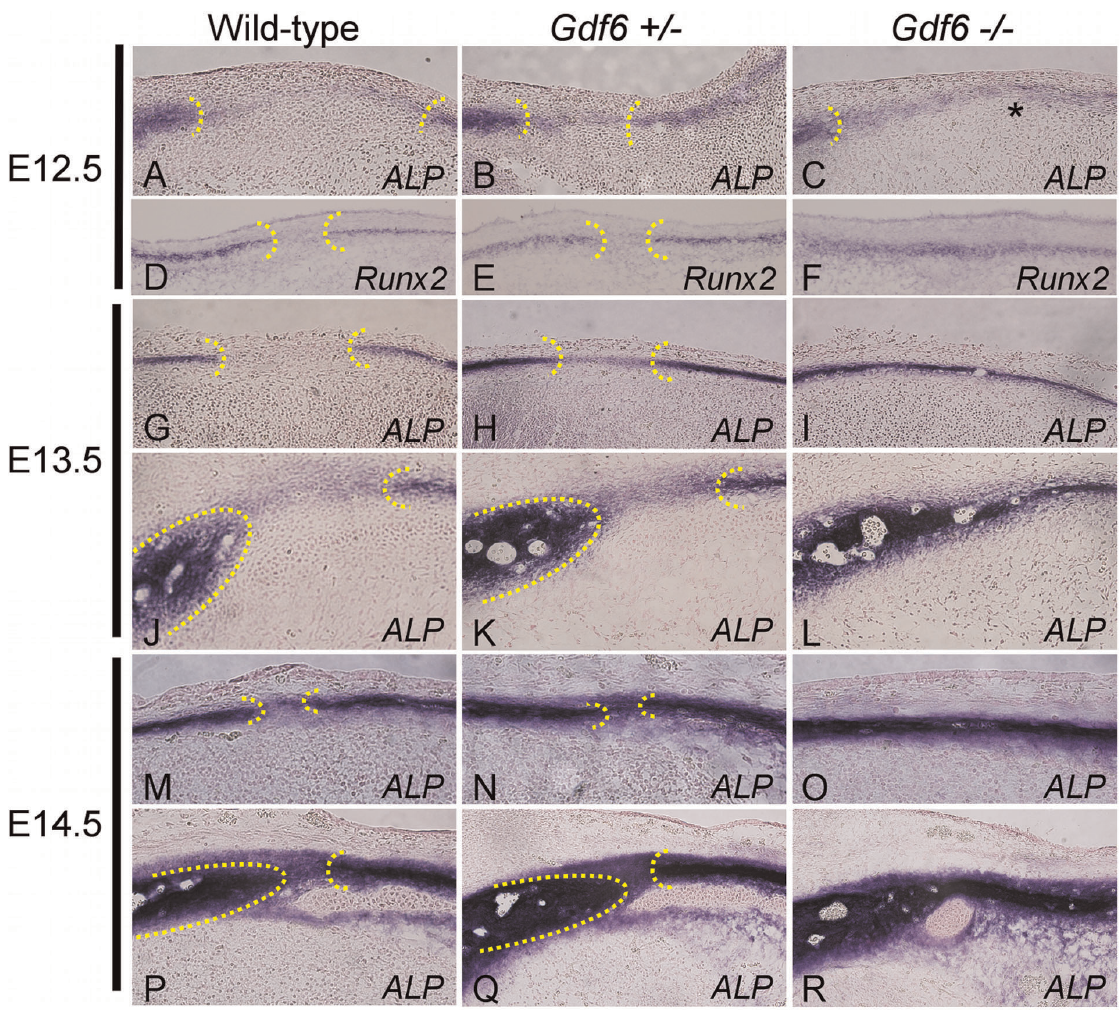
Figure 3. Alkaline-phosphatase (ALP) staining in the presumptive suture. Transverse sections through the E12.5 wild-type suture showed a gap in ALP activity between the frontal and parietal bones (A). The width of the gap was reduced in the Gdf6 + / 2 , with an increase in ALP activity within the suture (B). In the Gdf6 2 / 2 , there is a continuous line of ALP activity through the region, with a reduction in ALP activity in the parietal portion of the fused bone (C). Similar changes in ALP staining were observed in the E13.5 and E14.5 rostral (G–I, M–O) and caudal (J–L, P–R) coronal sutures and through in situ hybridization for Runx2 (D–F).